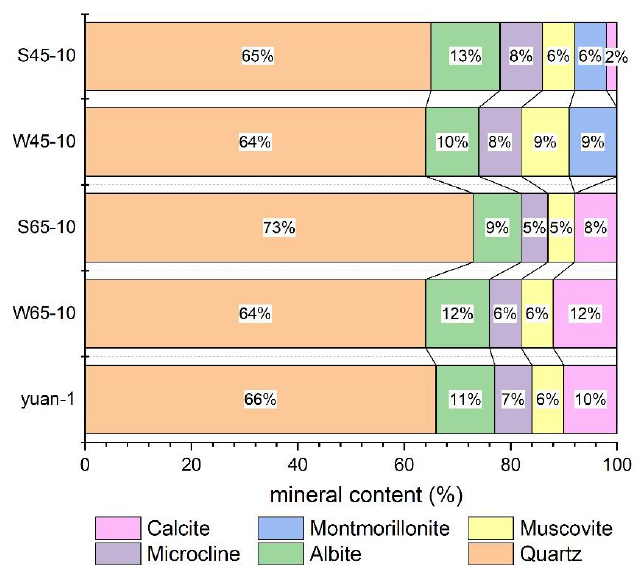
Figure 4. Mineral compositions of samples at different temperature